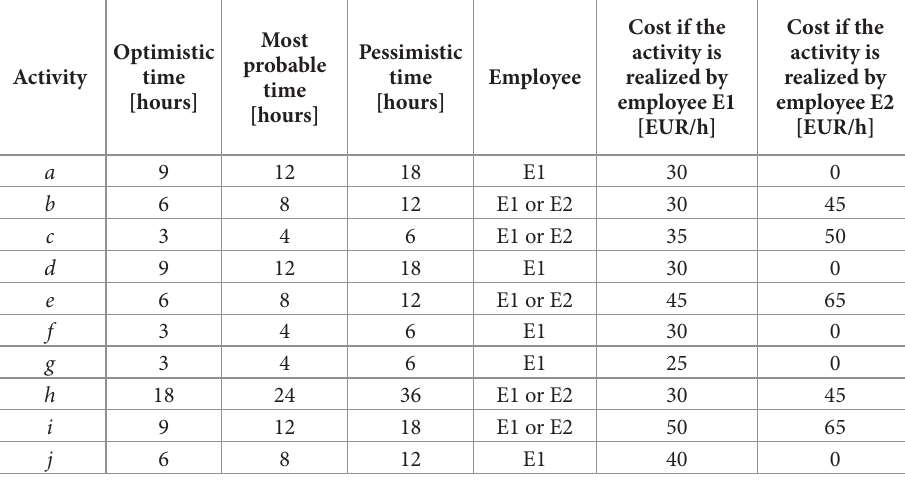
Table 1. List of activities